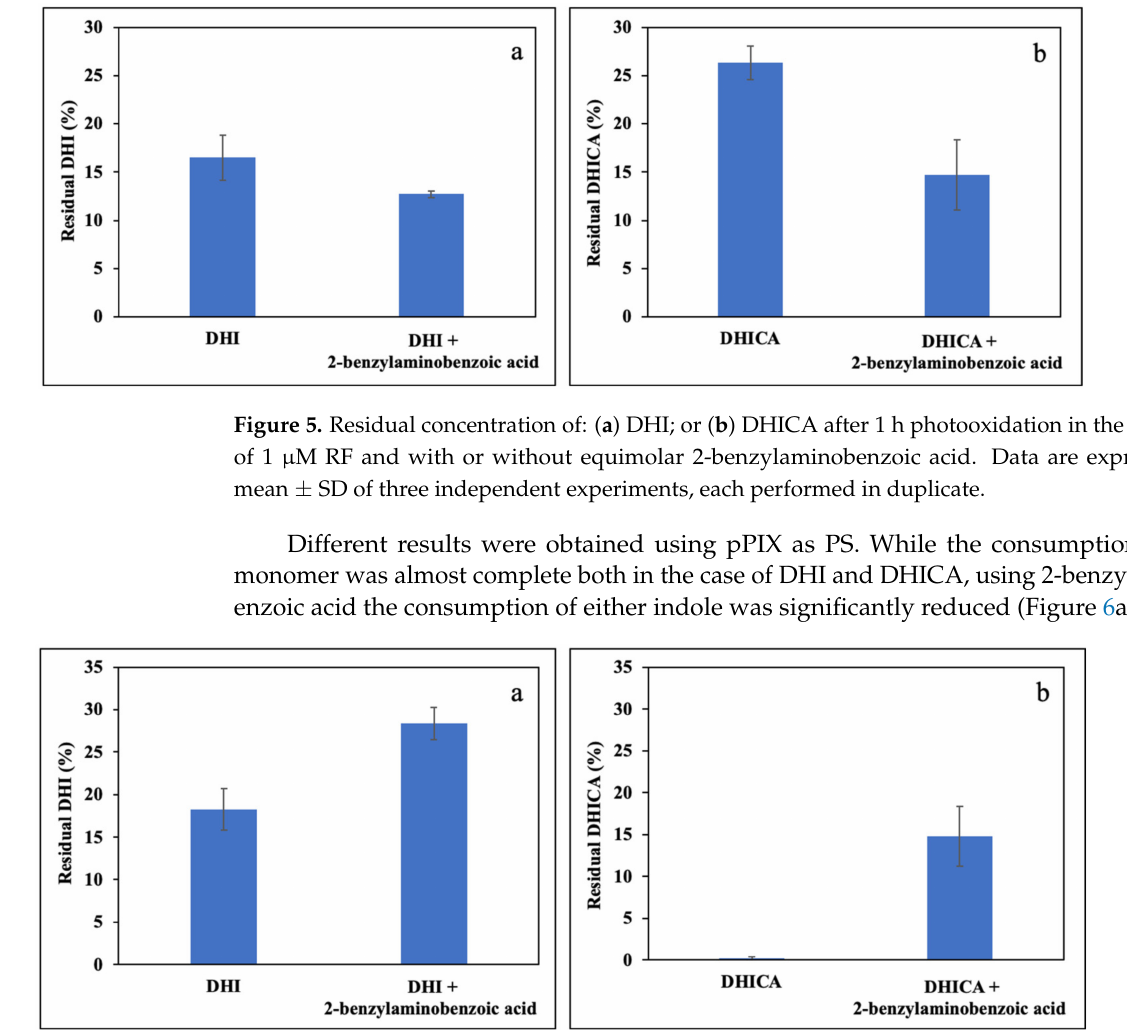
Figure 6. Residual concentration of: ( a ) DHI or ( b ) DHICA after 1 h photooxidation in the presence of 5 µ M pPIX and equimolar 2-benzylaminobenzoic acid. Data are expressed as mean ± SD of three independent experiments, each performed in